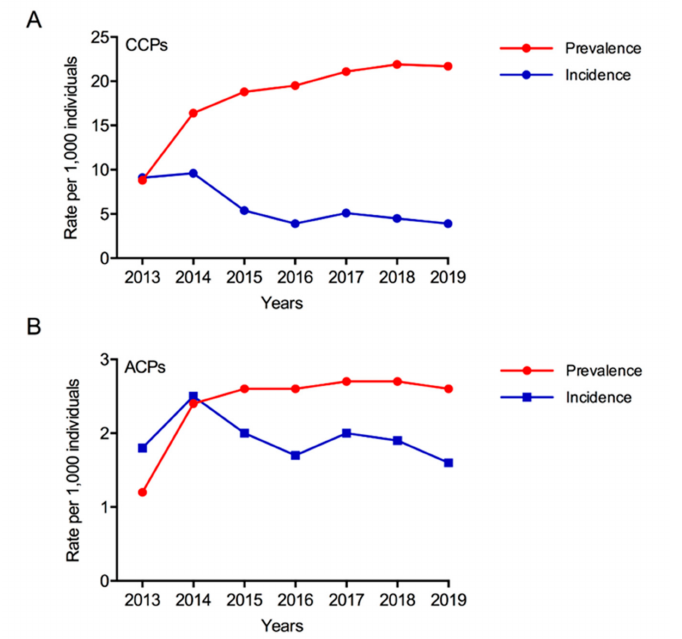
Figure 4. Prevalence and incidence rates of ( A ) CCPs and ( B ) ACPs throughout the study period